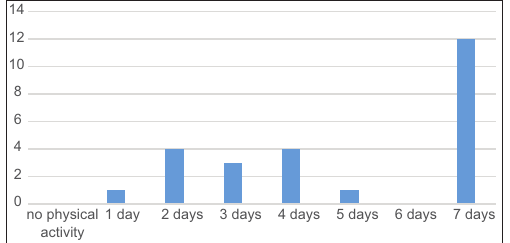
CHART 13. Frequency of walking without interruption of at least 10 minutes in free time. (less than a day - one day -. days)